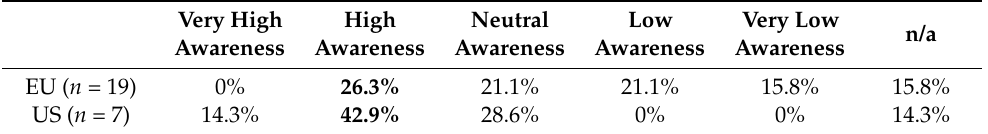
Table 7. EU and US companies’ awareness of TTIP.